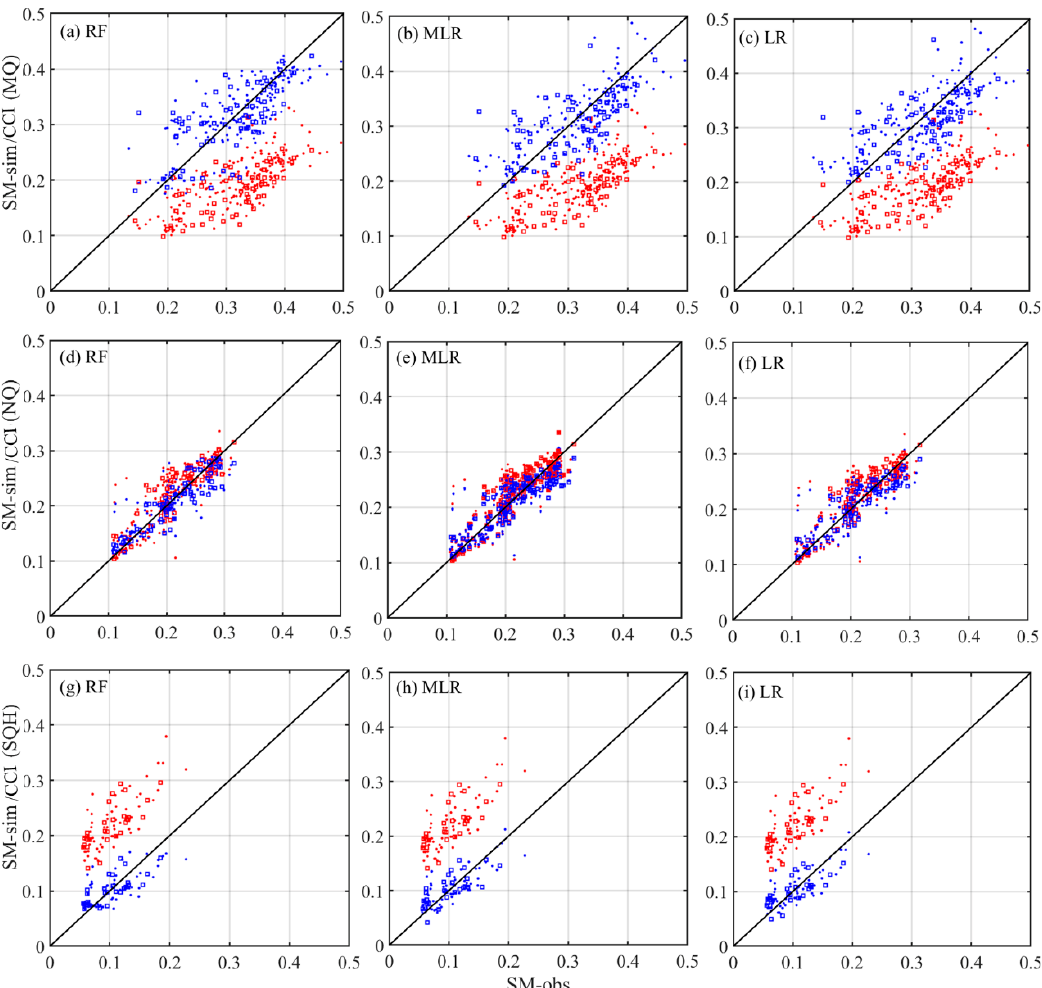
Figure 5. Contrast of the CCI-C SM data (red mark) versus the simulations (blue mark) by the fit models against the in-situ observed SMC data in the MQ, NQ, and SQH areas. RF: random forest; MLR: multiple linear regression; LR: simple linear regression. The diagonal lines represent a 1:1 line. Squares and dots represent the calibration data (70% of the total) and validation data (the remaining 30%), respectively. SM-obs: in-situ SM data; SM-sim/CCI: the data from model fits or the CCI-C dataset.